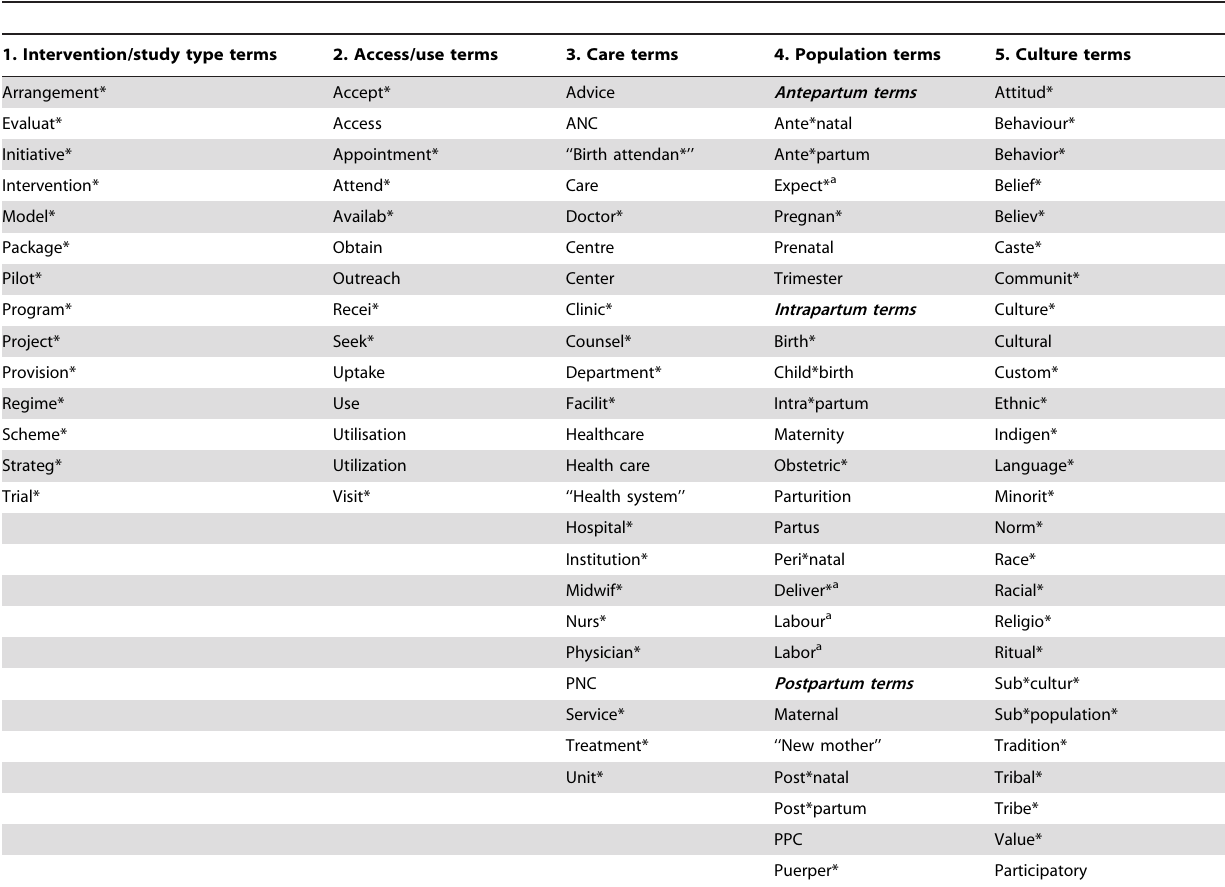
Table 2. Search terms and their